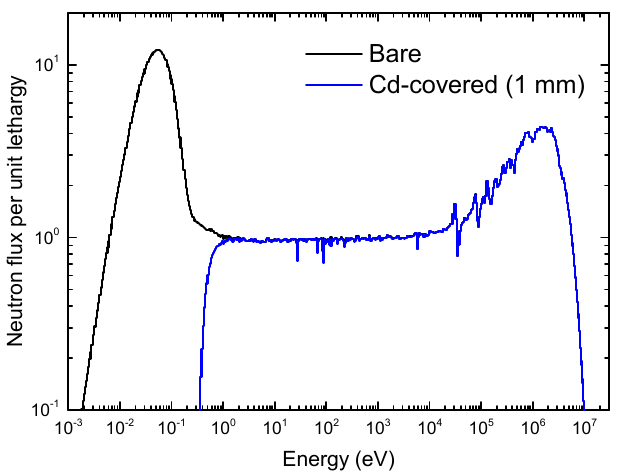
Figure 1. Neutron spectra in the Jozef Stefan Institute (JSI) TRIGA pneumatic tube (PT) irradiation channel, corresponding to bare and Cd-covered irradiations, obtained by means of Monte Carlo simulations and subsequently characterized on the basis of experimental neutron activation measurements.